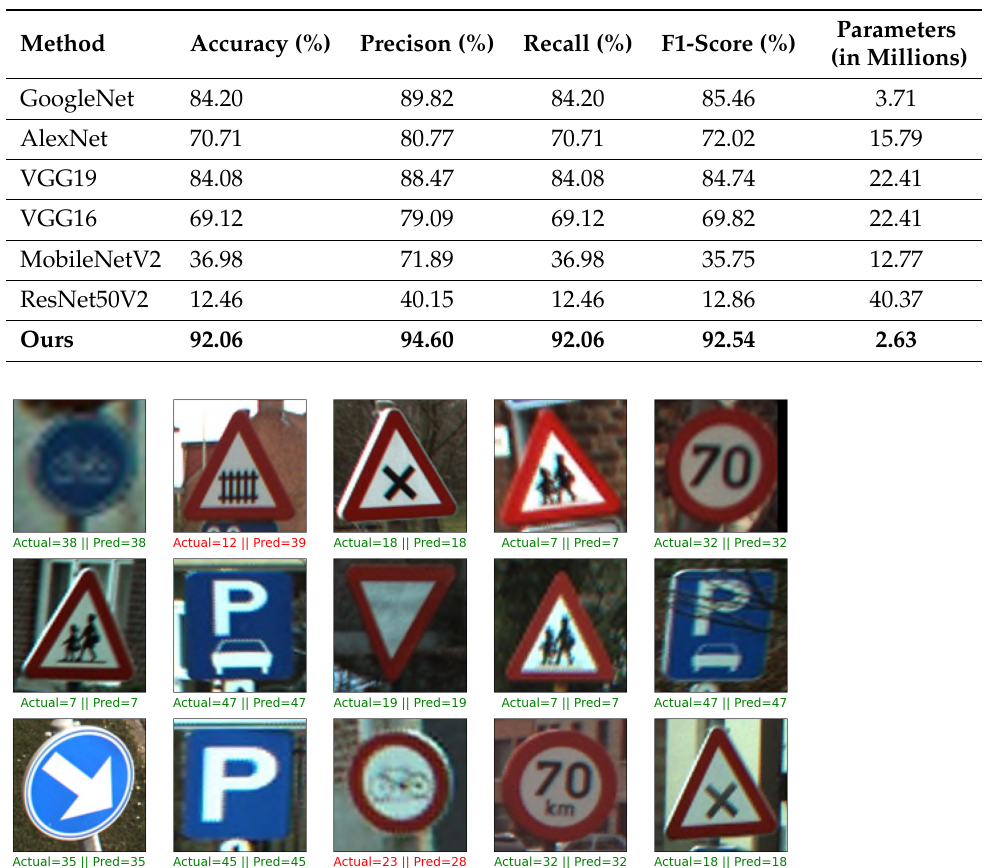
Table 5. Comparative analysis of detection performance on BelgiumTS.